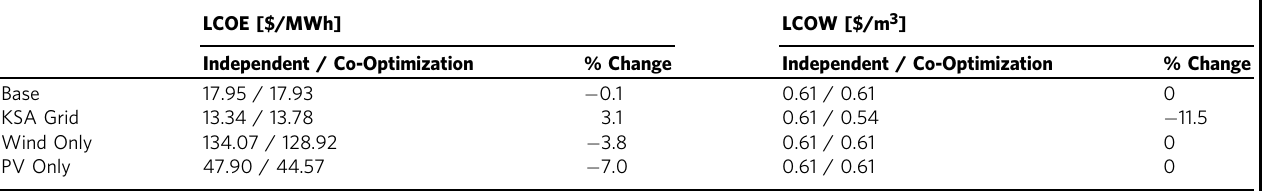
Table 4 Levelized cost of electricity (LCOE) and levelized cost of water (LCOW).